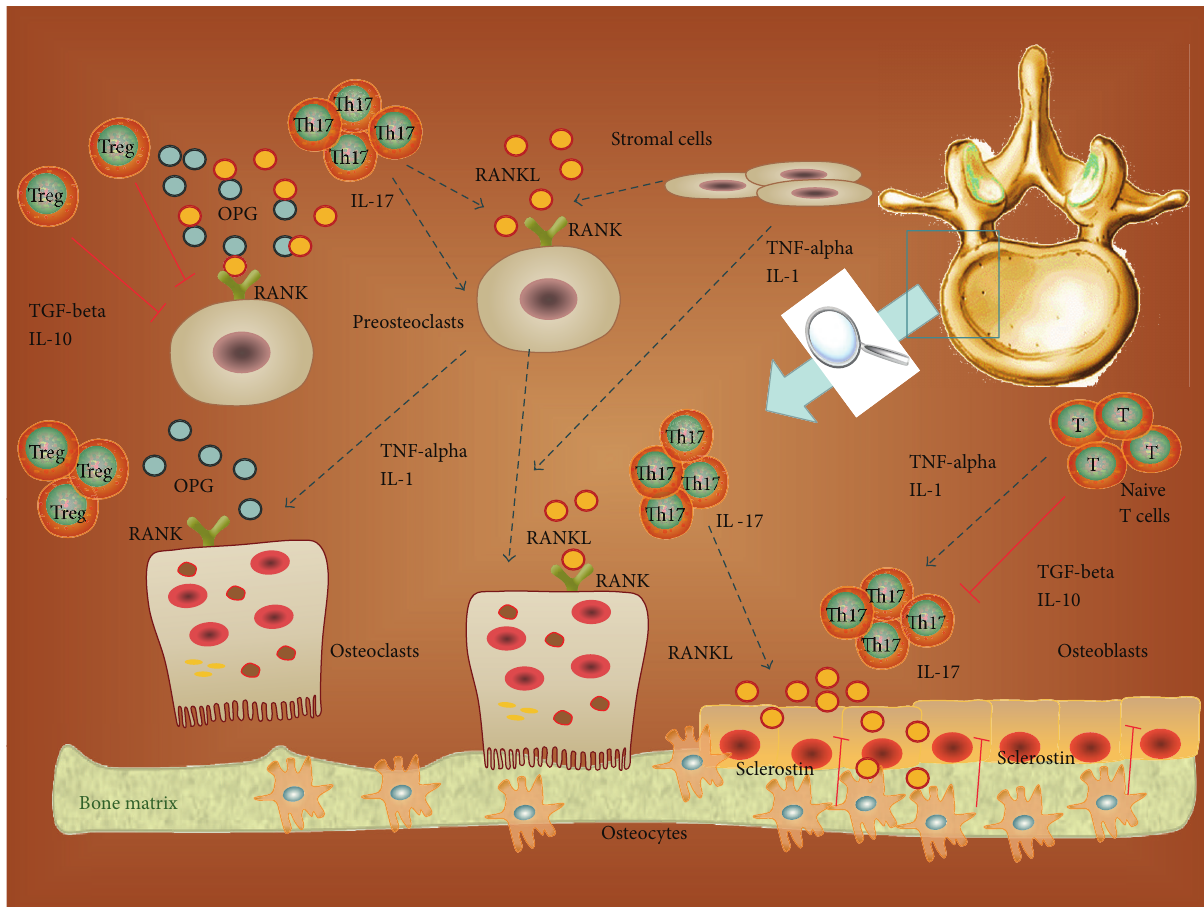
Figure 1: The complex cellular network of the “bone immunological niche.” OPG: